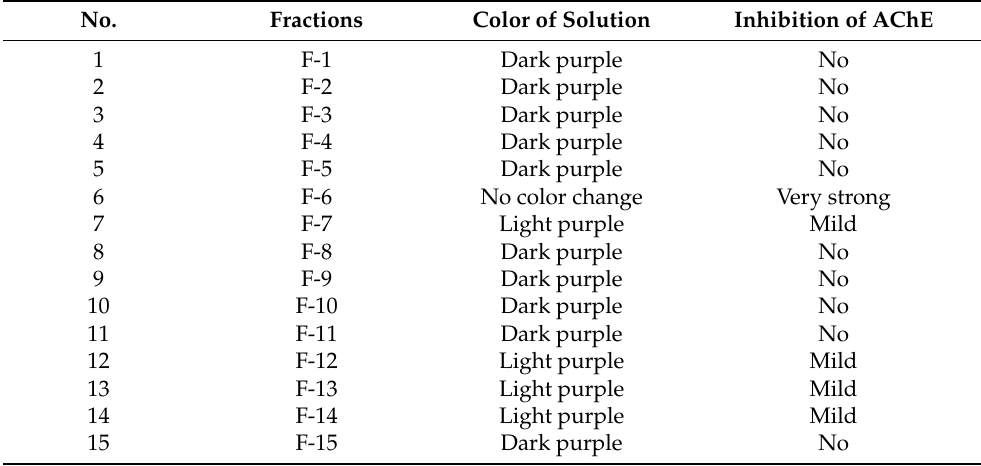
Table 3. Anti-cholinesterase activity (in vitro) shown by different fractions of L. stoechas.